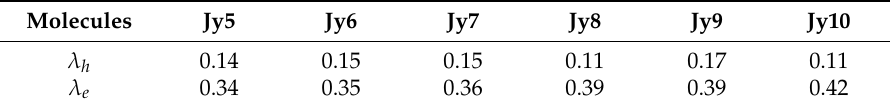
Table 3. The hole reorganization energies λ h (eV) and electron reorganization energies λ e (eV) of six investigated